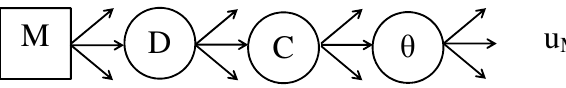
Figure 11. Decision tree for the manufacturer.